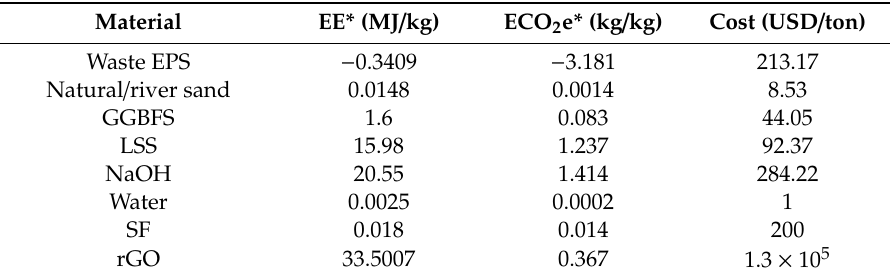
Table 6. Input parameters for calculating EE and ECO 2 e costs.